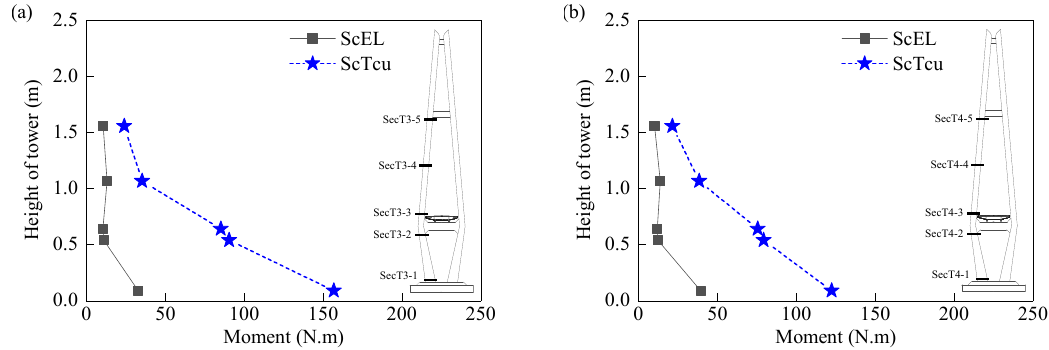
Figure 19. Moment of key sections along tower ( a ) 3# tower; ( b ) 4# tower.